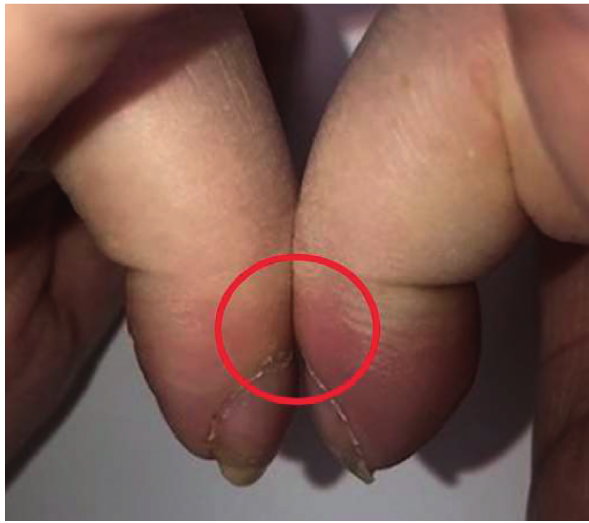
Figure 2: Schamroth sign, disappearance of normally appearing diamond-shaped window between dorsal pads of opposite terminal phalanges.